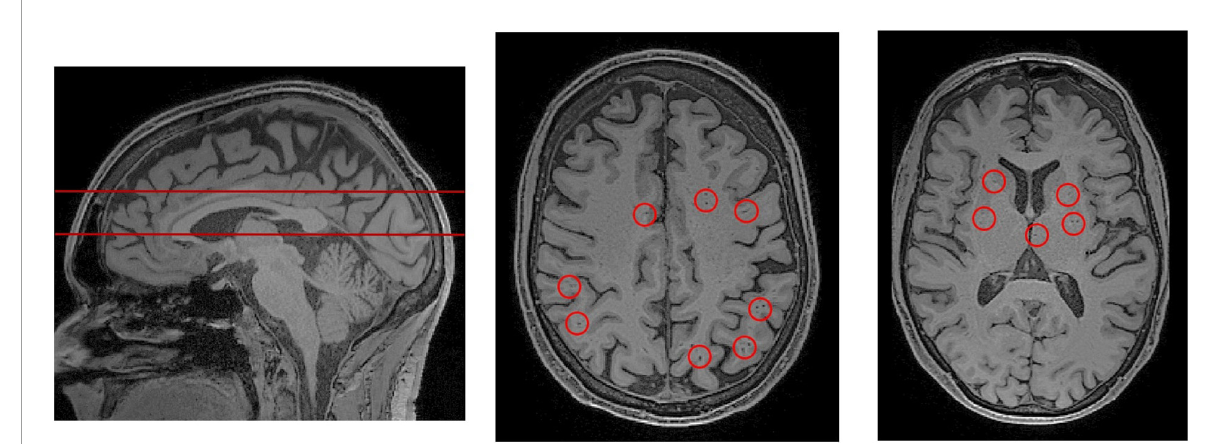
FIGURE3 PVS rating scales rely on representative axial slices to assess the severity of PVS enlargement. (Left) A sagittal view of the brain, from a T1-weighted MRI scan. The red lines indicate the axial slices that have been selected for visual PVS rating. The upper line was chosen to assess PVS in the centrum semiovale, and the lower line was chosen for the basal ganglia. The centrum semiovale is the mass of white matter above the lateral ventricles. (Middle) An axial slice of the centrum semiovale corresponding to the top line. (Right) An axial slice of the basal ganglia corresponding to the bottom line. Visible perivascular spaces are outlined by red circles. For an extensive review of rating scales, please refer to Paradise et al. (2020).